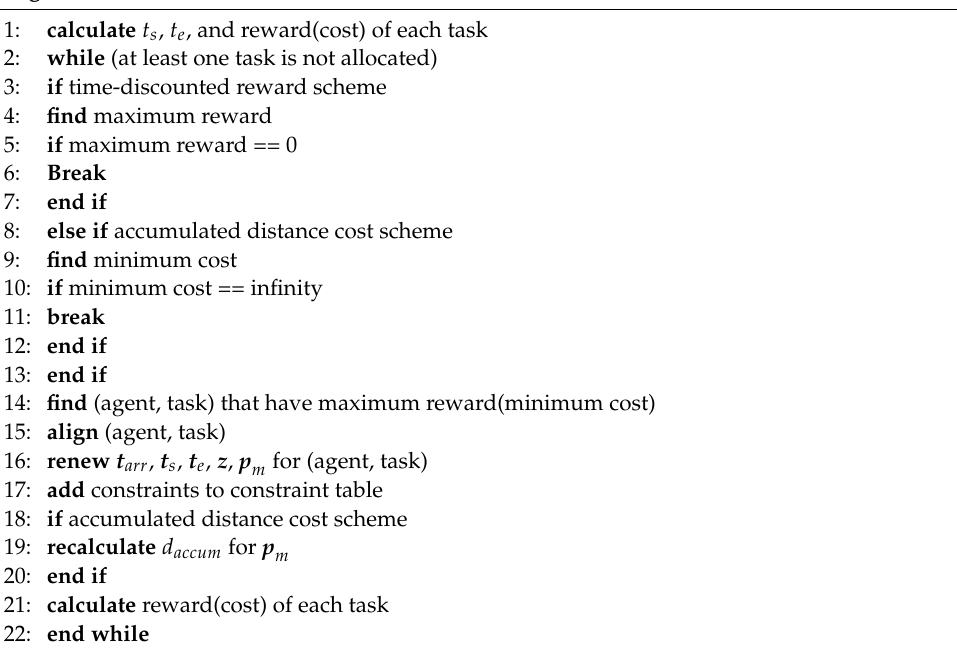
Algorithm 7 Centralized TACTAR: line 5 of main